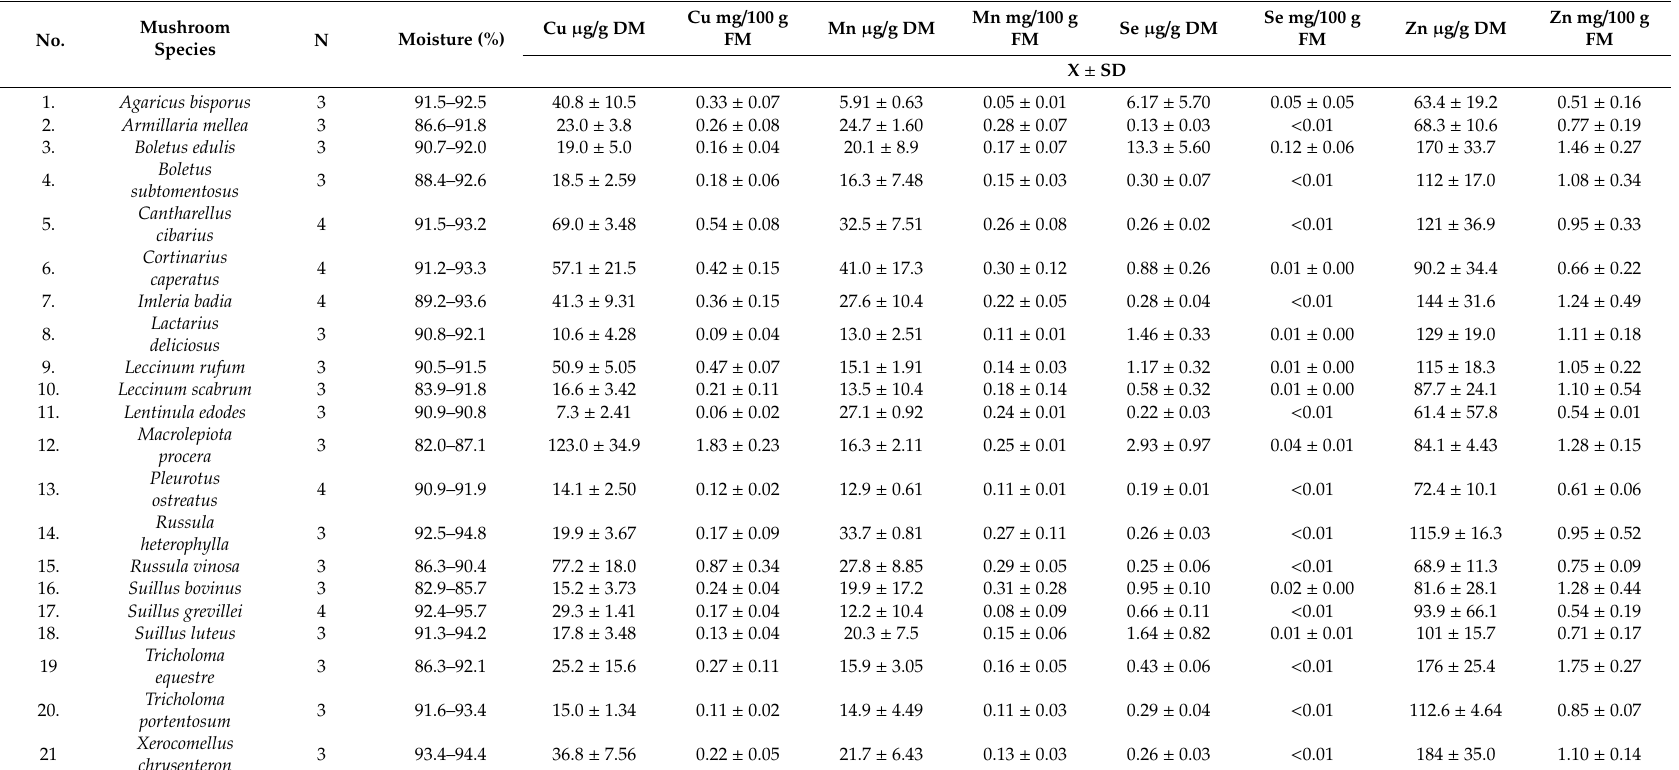
Table 1. Microelement content in wild and cultivated edible mushrooms in dry and fresh